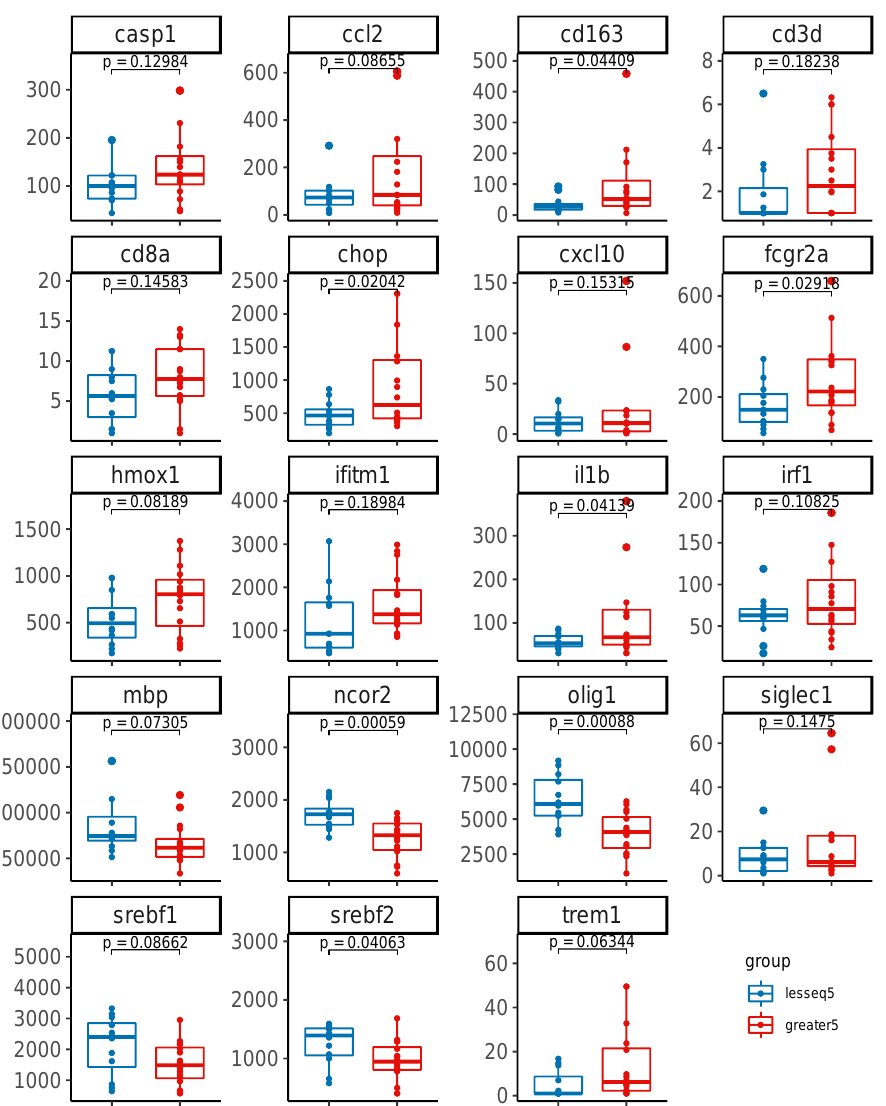
Figure 3. Differential expression of genes related to neuroinflammation and white matter integrity in groups stratified by level of intact proviruses in brain tissue from 28 HIV+ individuals on ART. Differential gene expression in brain tissue (frontal white matter) from 28 HIV+ individuals stratified by frequency of intact proviruses per 10 6 cells in brain tissue > 5 copies vs. ≤ 5 copies per 10 6 cells ( n = 12 and n = 16, respectively). Horizontal bars represent medians, boxes span the interquartile range (IQR), and whiskers extend to extreme data points within 1.5 times the IQR. p -values calculated using Welch ’ s t-test.